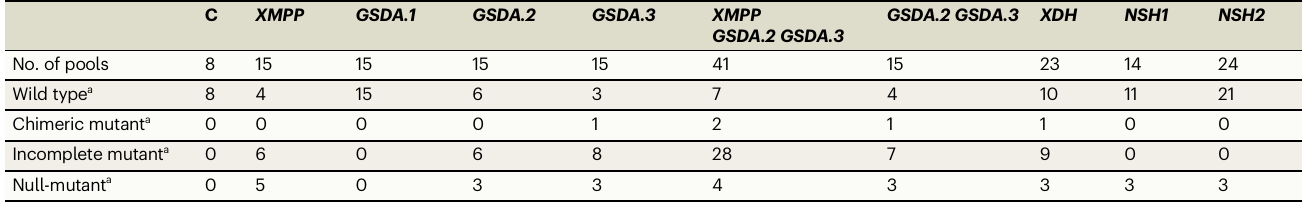
Table 2 | Overview of CRISPR-mediated mutations in target genes of Phaseolus